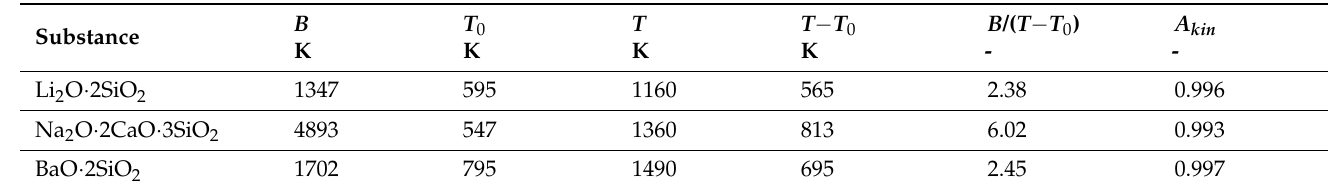
Table 3. Relative increase in the nucleation rate I ( T + δ T )